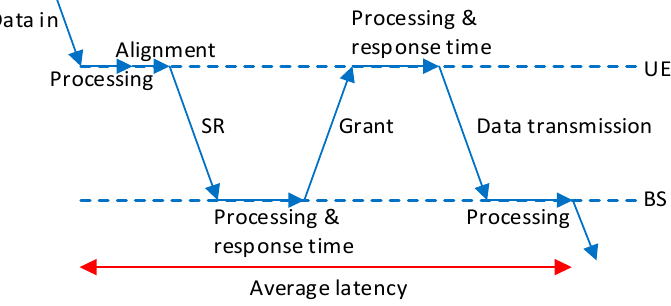
Figure 8. Latency introduced in grant-based scheduling.